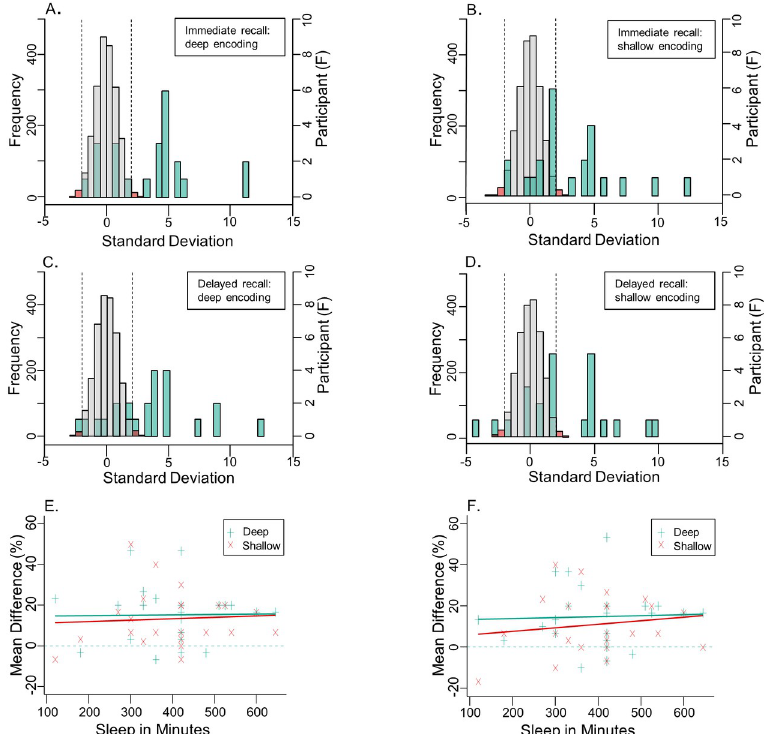
Fig 5. Depth of encoding resampling and sleep data. Histograms ( A , B , C , & D ) depict the resampling analysis for the depth of encoding task in the MBO group. The left y axis’ show the frequency of resampled mean differences, converted into z-scores, between before-alcohol minus after-MBO conditions for the immediate recall, deep encoding ( A ), immediate recall, shallow encoding ( B ), delayed recall, deep encoding ( C ), and delayed recall, shallow encoding ( D ) conditions. In all panels bar width is 0.5 standard deviations. Grey bars depict roughly 95% of the resampled distribution, and the red bars show the 2.5% tails at either side, demarcated by vertical dashed lines. Overlaid green bars are a separate histogram (right y axis) showing the frequency of participants’ mean differences (z-scores), with the same bar width of 0.5 standard deviations. ( E ) scatterplot displays the difference between the mean accuracy (%) for immediately recalled words in the depth of encoding task, before-alcohol minus after-MBO , correlated with reported minutes slept, within the MBO group. ( F ) shows the same as ( E ), except for the delayed recall conditions.